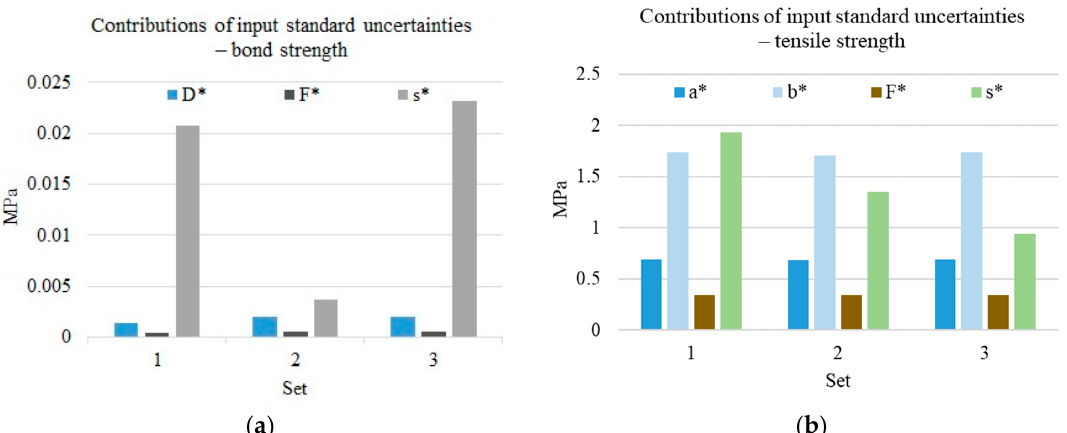
Figure 6. Contributions of input standard uncertainties: ( a ) D , F and A σ contributions to bond strength combined uncertainty. Sets of bars 1 and 2 have been obtained for two laboratories with different actual standard deviation (II approach), set 3 was obtained for laboratory 2 which used reproducibility standard deviation. D * is the ∂ D u D , F * is ∂ F u FB , and A * is ∂ A σ u A σ . ( b ) a , b , F , and A σ contributions to ABS tensile strength combined uncertainty. Set 1 is based on reproducibility standard deviation from ISO 527-2; set 2 is based on reproducibility standard deviation obtained in DRRR inter-laboratory experiment; set 3 is the actual standard deviation of an exemplary laboratory. a * is the ∂ a u a , b * is the ∂ b u b , F * is ∂ F u FB , and s * is ∂ A σ u A σ .